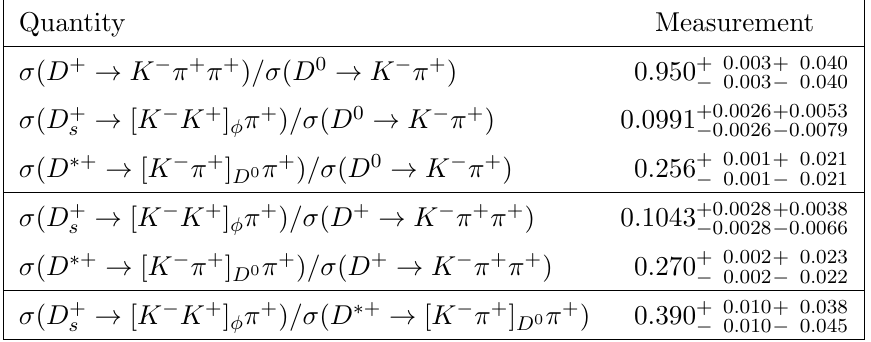
Table 4. Ratios of integrated cross-section-times-branching-fraction measurements in the kine- matic range 1 < p T < 8 GeV = c and 2 < y < 4 : 5. The (cid:12)rst uncertainty on the ratio is statistical and the second is systematic. The notation (cid:27) ( D